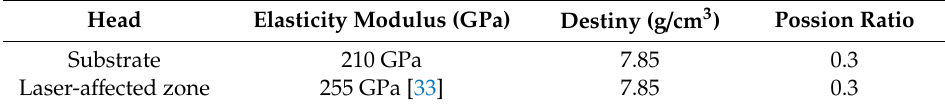
Table 3. The parameters used in the finite element method (FEM).